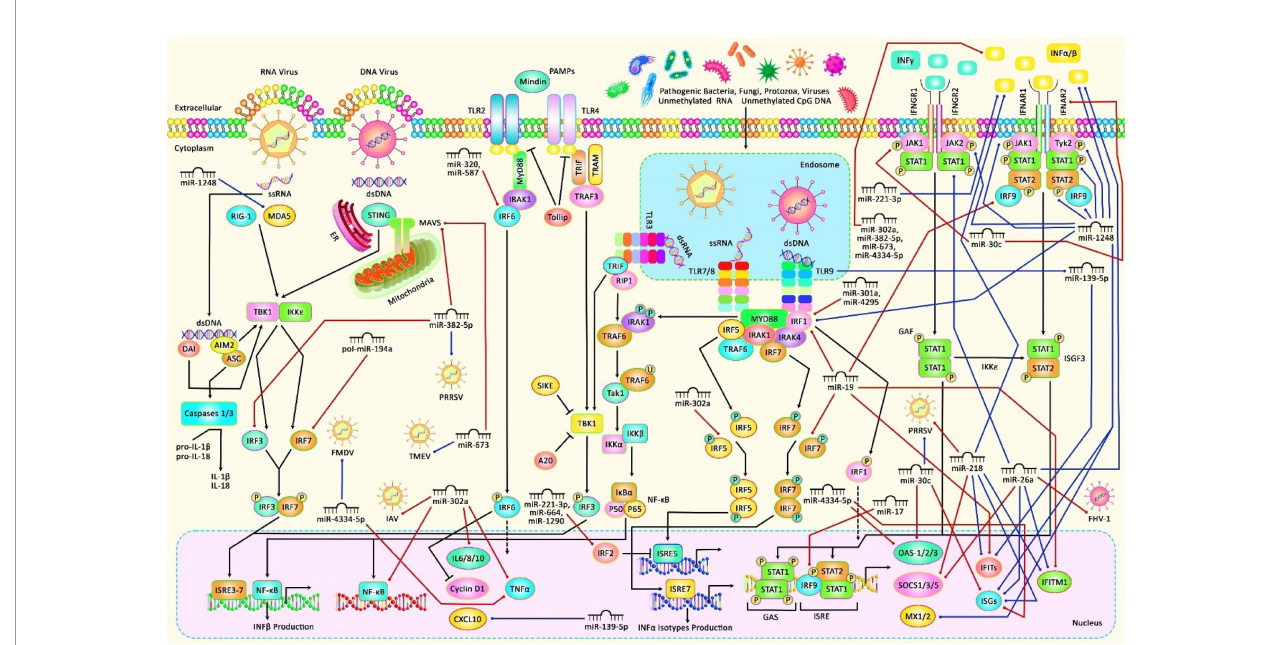
FIGURE 1 | A schematic diagram of the interaction between several miRNAs and interferons in causing various human diseases. Mounting evidence has demonstrated that miRNAs could have an important contribution to the regulation of expression of IFN-induced genes. Aberrant expression of such ncRNAs could lead to various human diseases such as major depressive disorder, Sjögren ’ s Syndrome, Systemic Sclerosis as well as different kinds of cancers. As an illustration, a recent study has detected that overexpression of miR-301a could promote hepatocellular carcinoma via directly targeting IRF1 (9). Moreover, another research has fi gured out that miR-587 could play a key role in the progression of cervical cancer by down-regulating the expression of IRF6 (19). In addition, another fi nding has denoted that miR-1248 via activating the expression levels of IFN- b , IRF1/9, MX1, JAK-1/2, STAT-1/2, TYK2 as well as direct association with both AGO2 and RIG-I could have a crucial role in Sjögren ’ s syndrome (25). Furthermore, miR-26a could suppress feline herpesvirus 1 (FHV-1) replication via targeting SOCS5 and up- regulating the expression levels of IFN- a , IFN- b , ISG-15, STAT-1, and IFITM1 in type I IFN signaling (37). Blue lines indicate the positive regulatory effect among miRNAs and their targets, and crimson lines depict negative effects among them. All information regarding the role of these miRNAs in the modulation of the IFN signaling cascade in various types of human diseases and cancers can be seen in Tables 1 and 2